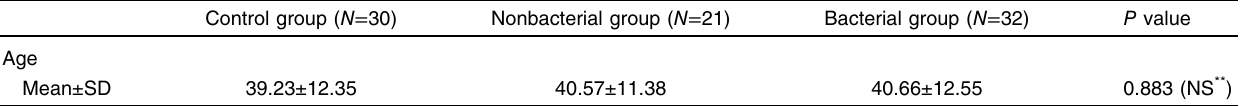
Table 1 Mean age in the studied